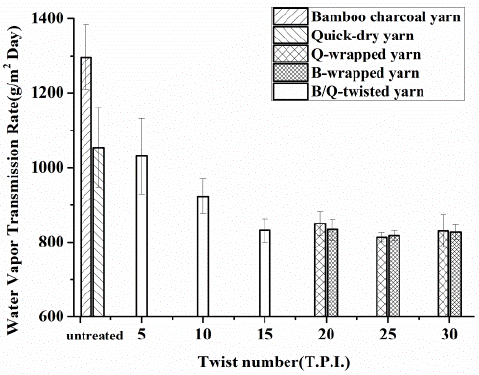
Figure 12. Water vapor transmission rate of functional elastic knits in relation to the administration of a wrapping/twisting process as well as the twist number of the yarns. The error bar indicates the